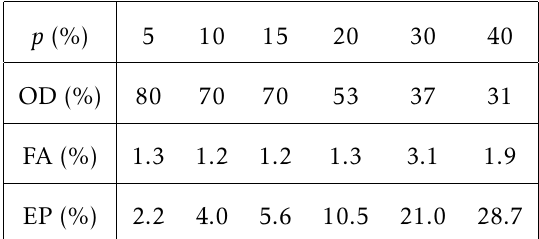
Table 2. The Nearest Distance Based Simulation Result ( p Indicates Prior Error Probability), OD denotes Outlier Detection, FA denotes False Alarm and EP denotes Error Probability.)